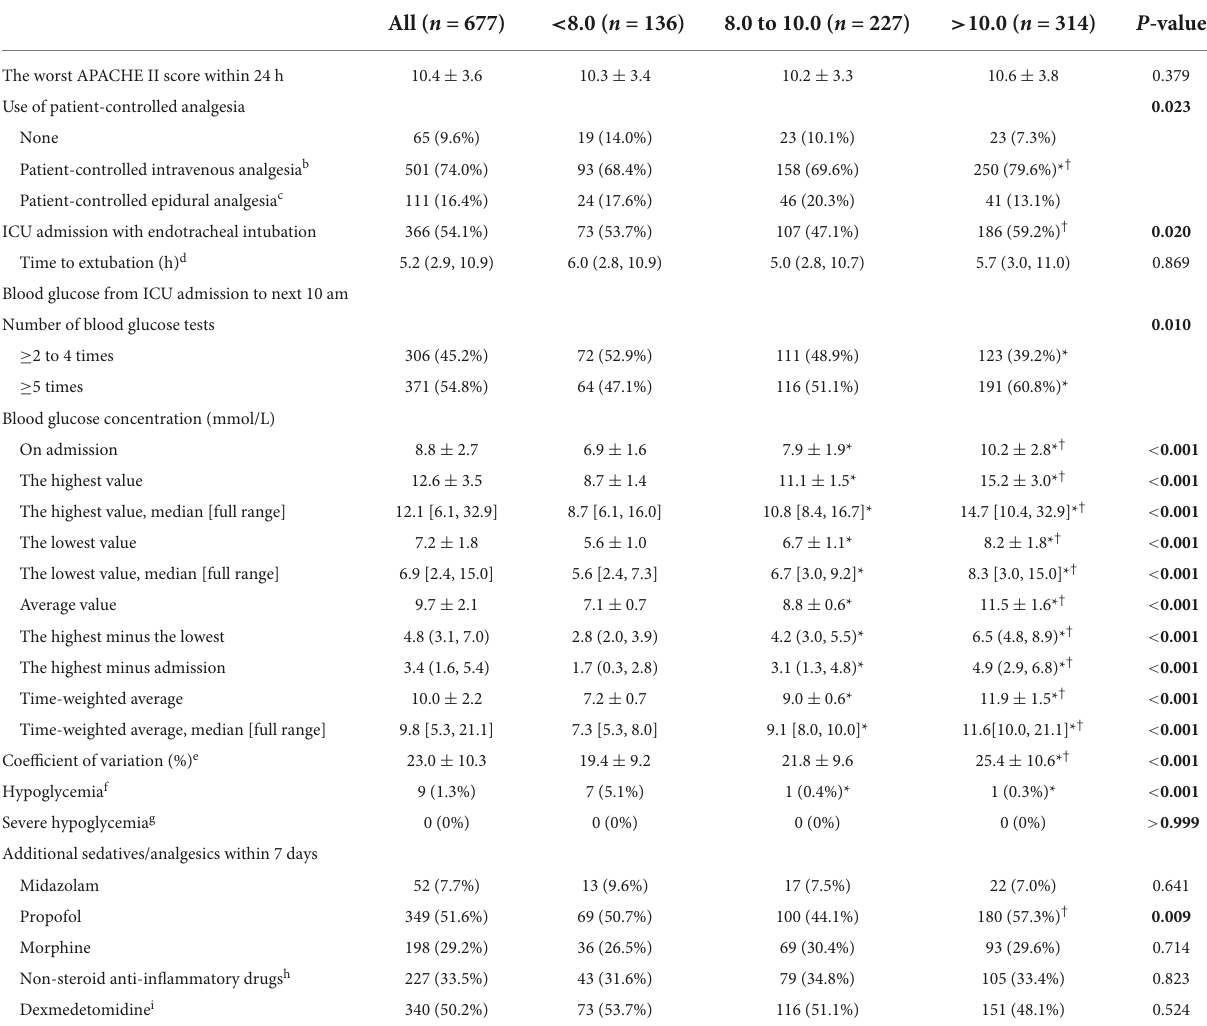
TABLE 3 Postoperative data.